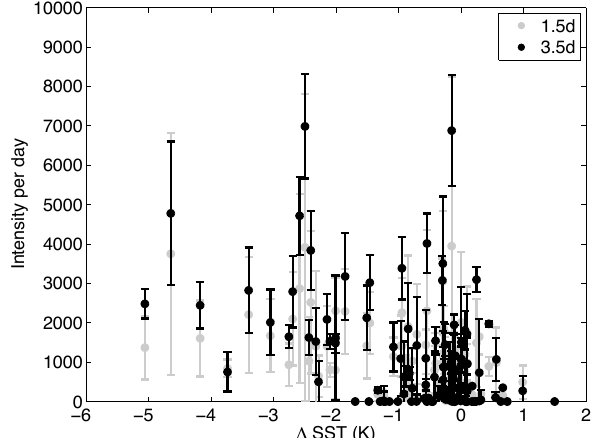
Figure 9. Wind impulse per day over the 1.5 and 3.5 days before the individual BE survey versus SST difference between Kiel light- house and BE surveys between 1988 and 2012 (compare also Ta- ble A1). The standard deviation in wind impulse over the respective periods (1.5 and 3.5 days) is indicated by the error bars (see Table 1 for details on most extreme events). Note that events without SST anomaly are not shown in this figure but in Table